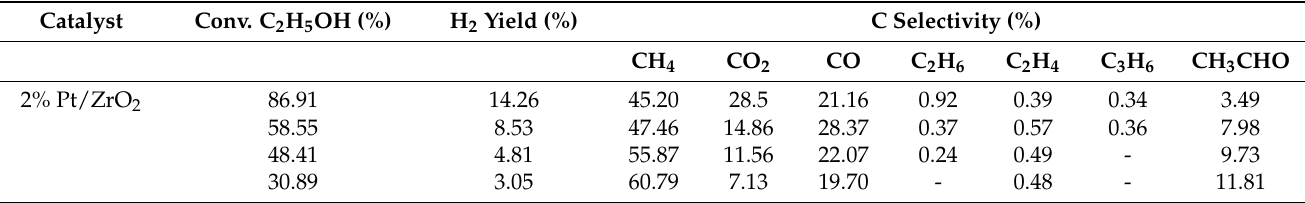
Table 4. ESR catalytic activity for 2% Pt/ZrO 2 catalyst at different C 2 H 5 OH conversion (300 ◦ C, 1 atm, feed: C 2 H 5 OH 2.98% H 2 O 26.14% N 2 70.88%).